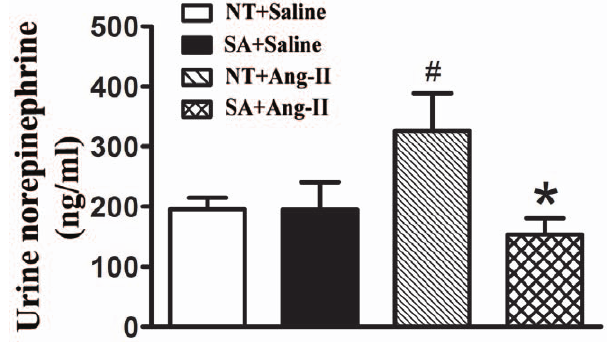
Figure 4. Urine NE levels. Mice were infused with Ang II or saline for 2 weeks. Urine were collected in 6 N HCl and processed for NE measurements using ELISA methods. Two weeks of Ang II infusion significantly increase urine NE levels compared to saline infusion in NT mice. However, the NE levels is significantly lower in SA compared NT at the end of 2 weeks infusion. N=4/group. Statistical significance: * P , 0.05 vs. NT with the same treatment; # P , 0.05 vs. saline with the same